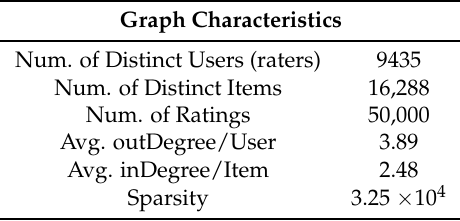
Table 2. Characteristics of the Epinions subset used in the